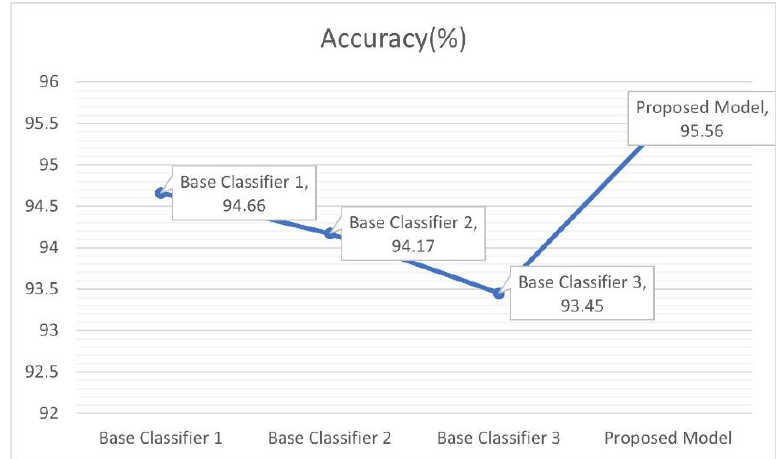
Figure 6. The accuracy of the above four models.